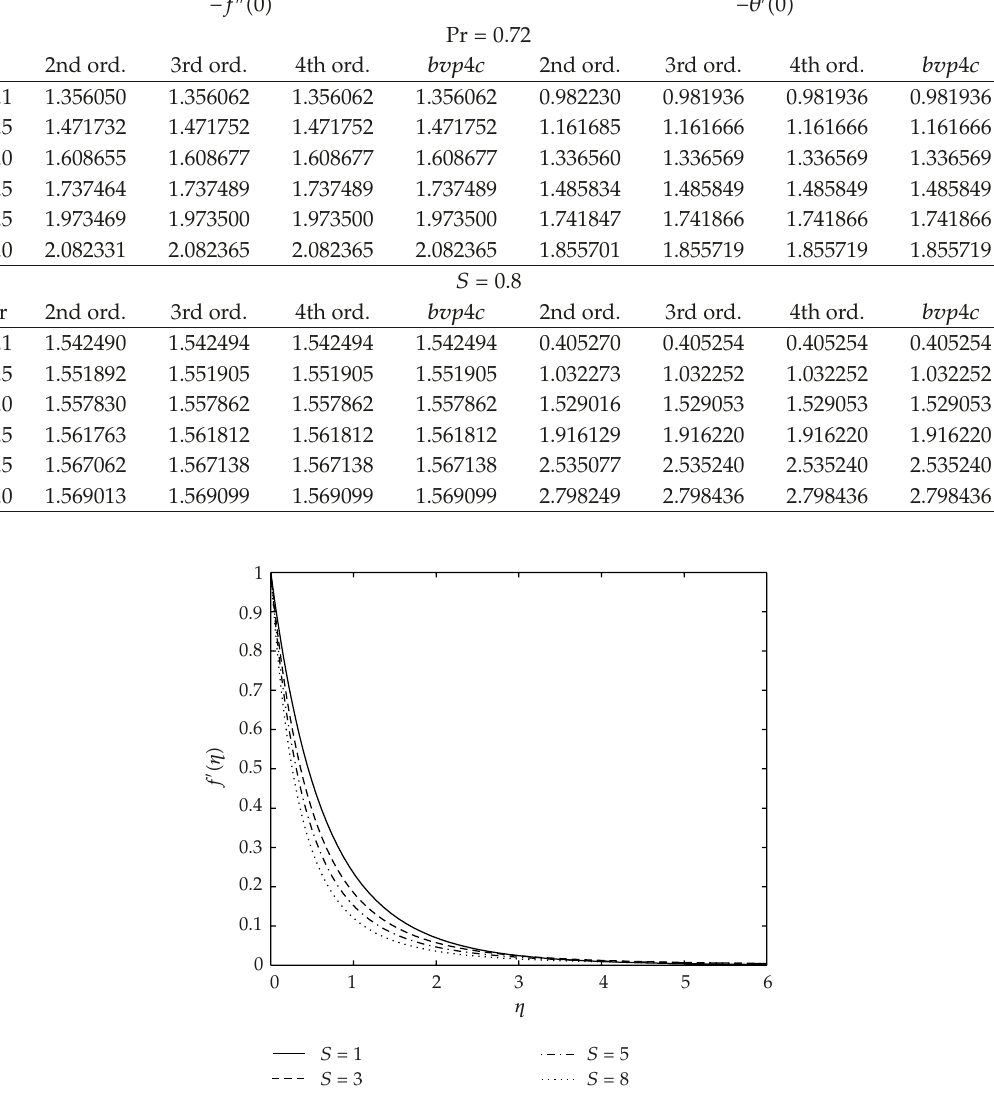
Figure 2: The variation axial velocity distributions with increasing values of S with M (cid:5) 1, Pr (cid:5) 0 . 72, m (cid:5) 1, β 1 (cid:5) 0 . 1, and β 2 (cid:5) 0 . 1